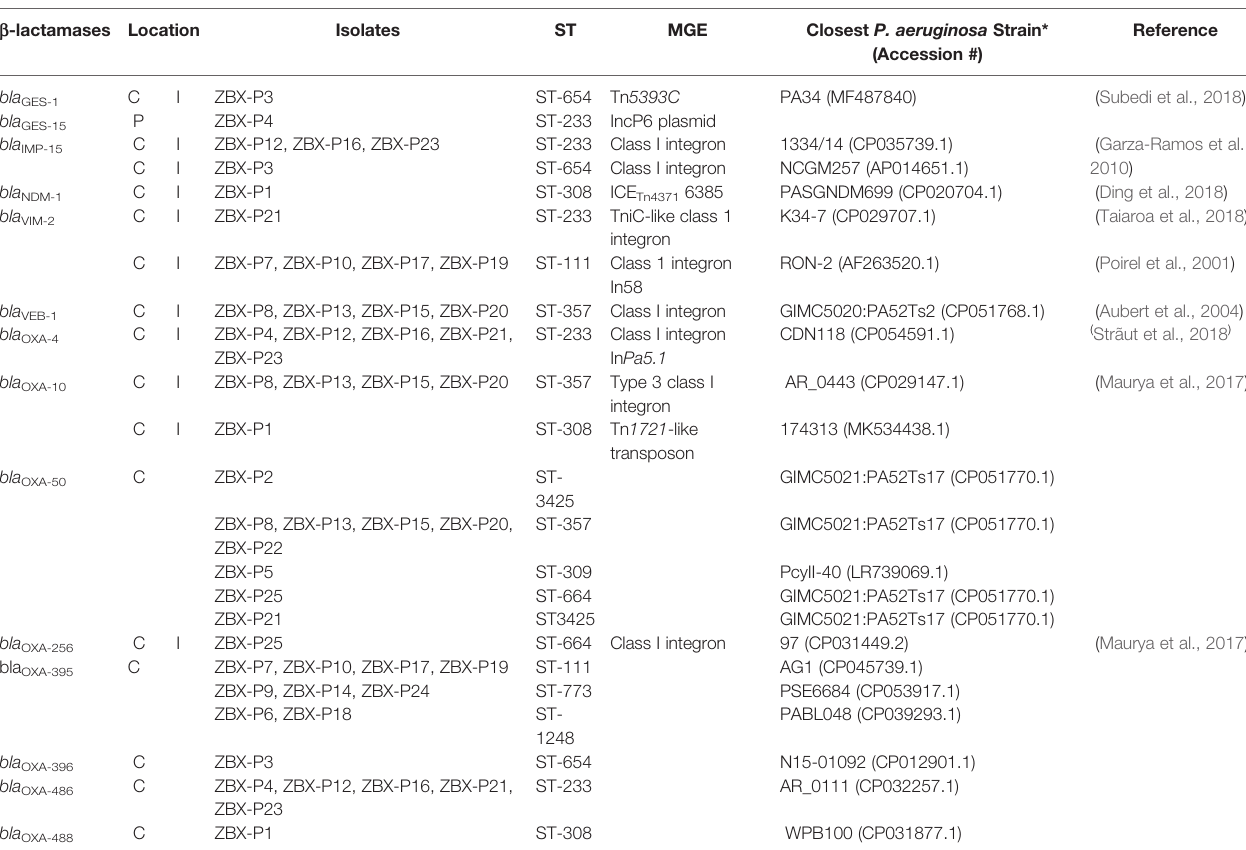
TABLE 1 | Genetic environment of detected b